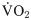
Simultaneous measurements of daily rhythms in oxygen consumption (V˙O2), body temperature (Tb), gross motor and wheel-running activity of tuco-tucos.Left: temporal series collected when the animal was inside the respirometry chamber, with and without a running-wheel. Shaded areas indicate dark phases and white areas light phases. Right: actograms across experimental conditions. Pink and blue backgrounds indicate data from animals inside the respirometry chamber, with and without access to wheels, respectively. (A) Representative individual that did not switch phase inside the respirometry chamber. Pink line in the left figure indicates introduction of the wheel to the chamber. (B) Representative individual that switched from nocturnal to diurnal inside the respirometry chamber. There was a 7-day interval outside the respirometry chamber before the wheel introduction due to technical problems. Pink broken line in the right figure separates days with and without wheels. General conditions: LD12:12 (L = 200–250 lux), 25±2°C and food ad libitum.